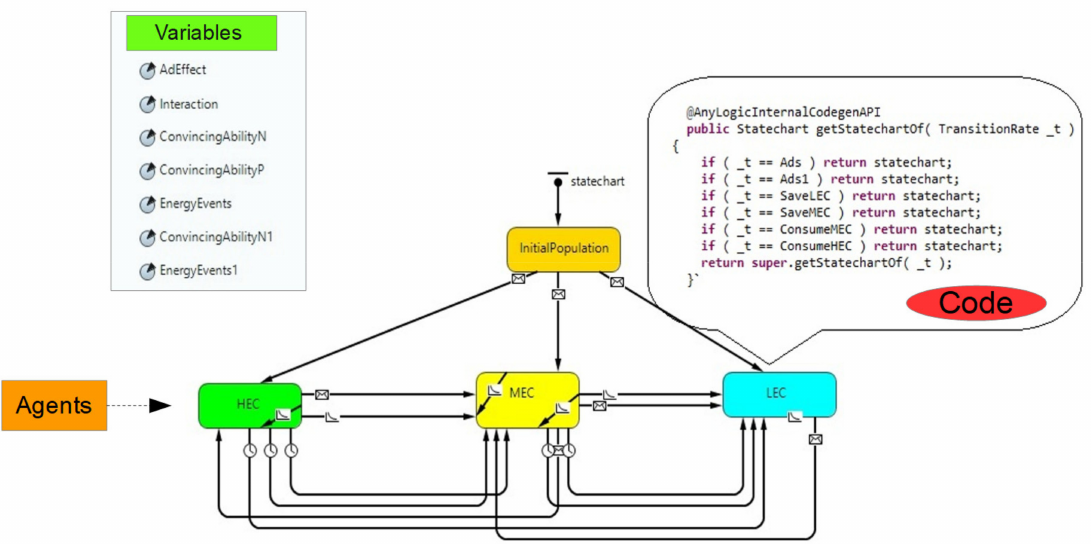
Figure 3. Model statechart showing the interactions of agents, the variables and the input code. Note: HEC means High Energy Consumers, MEC means Medium Energy Consumers, and LEC means Low Energy